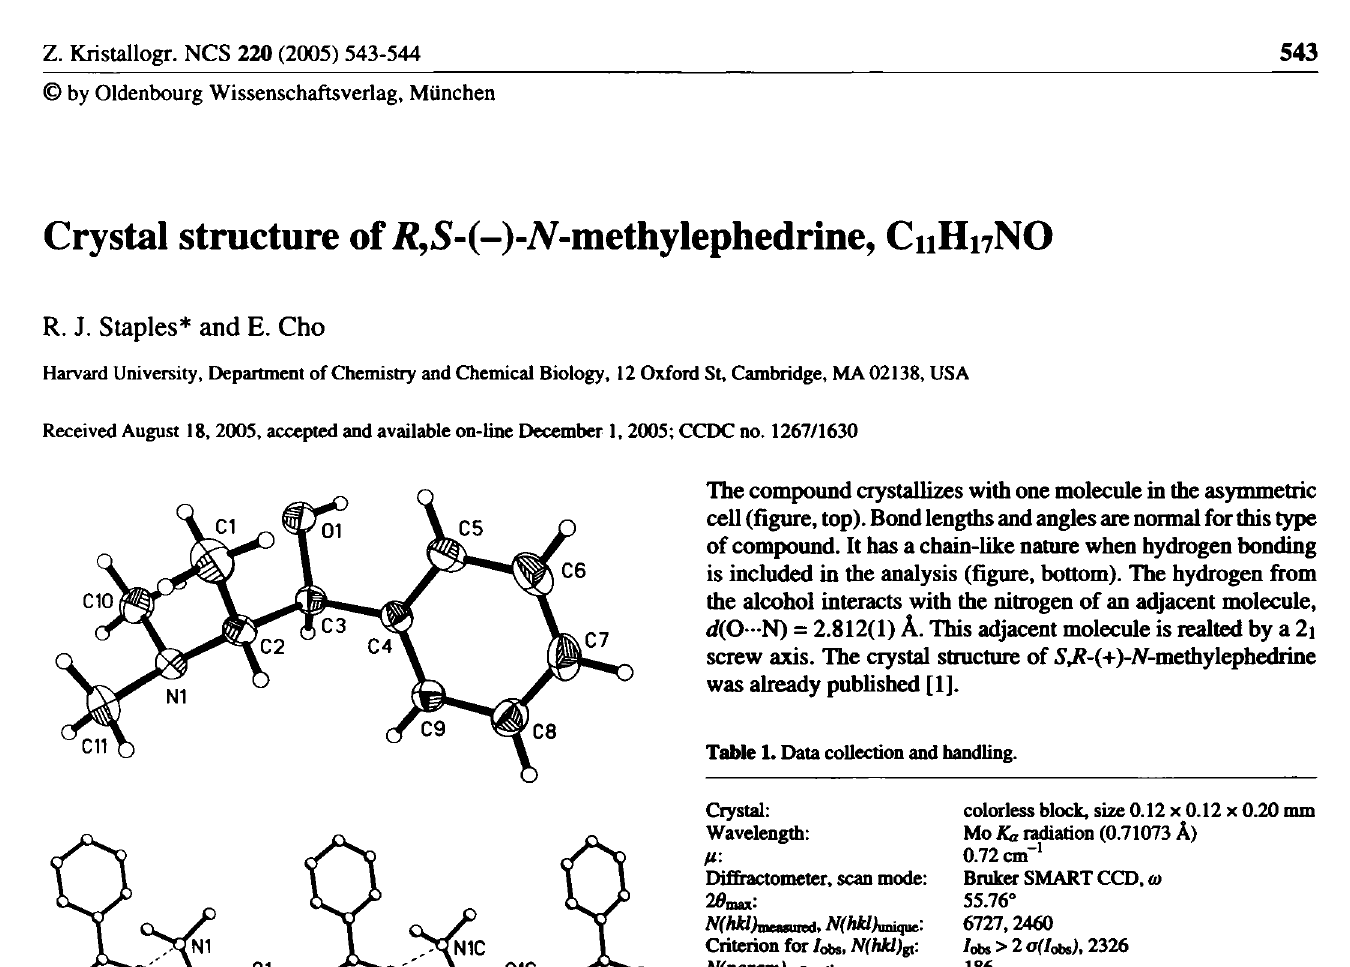
Table 2. Atomic coordinates and displacement parameters (in A 2